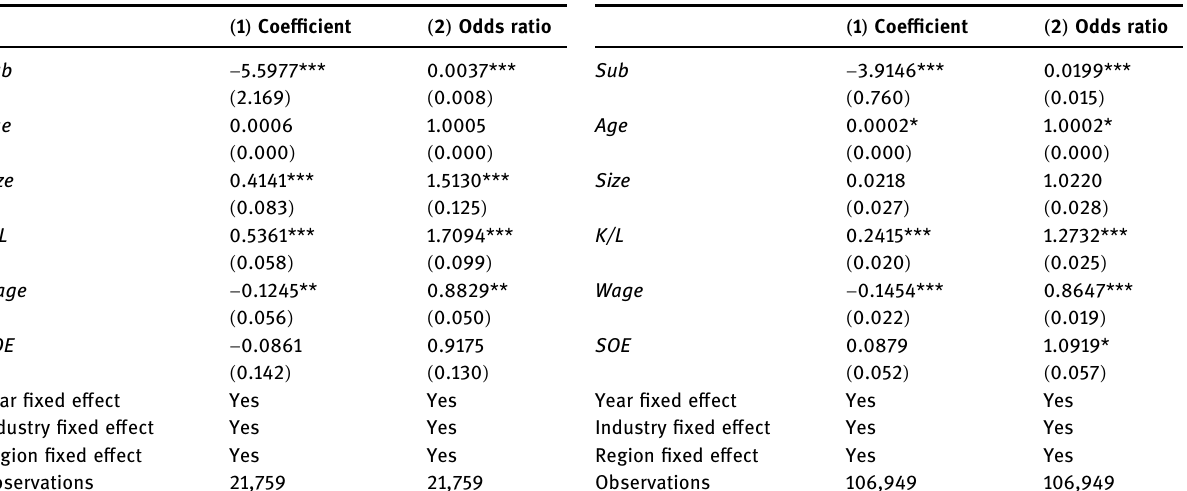
Table 13: Impact of fi scal subsidies on the probability of resurrec